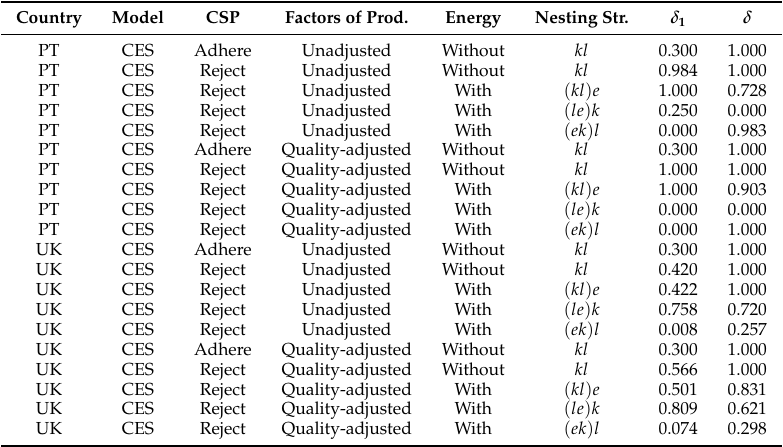
Table A2 shows estimated values of distribution parameters ( δ 1 and δ ) for all modeling approaches. Table A2. Distribution parameters ( δ 1 and δ ) for all modeling approaches.